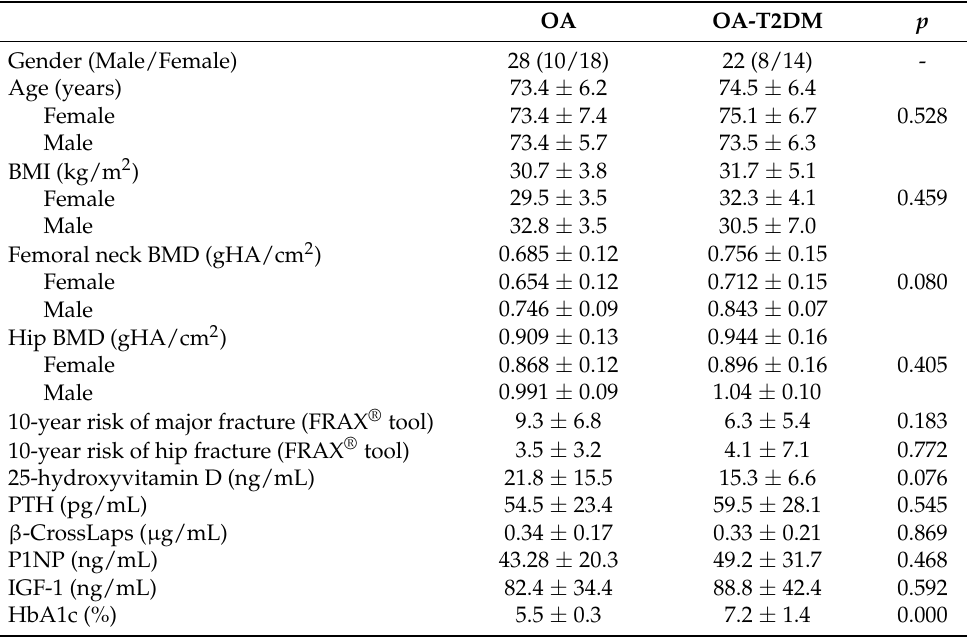
Table 1. Patient characteristics (total and by gender) and analyzed parameters. Values are shown as the means ± standard deviation (SD). BMI, body mass index; BMD, bone mineral density; PTH,